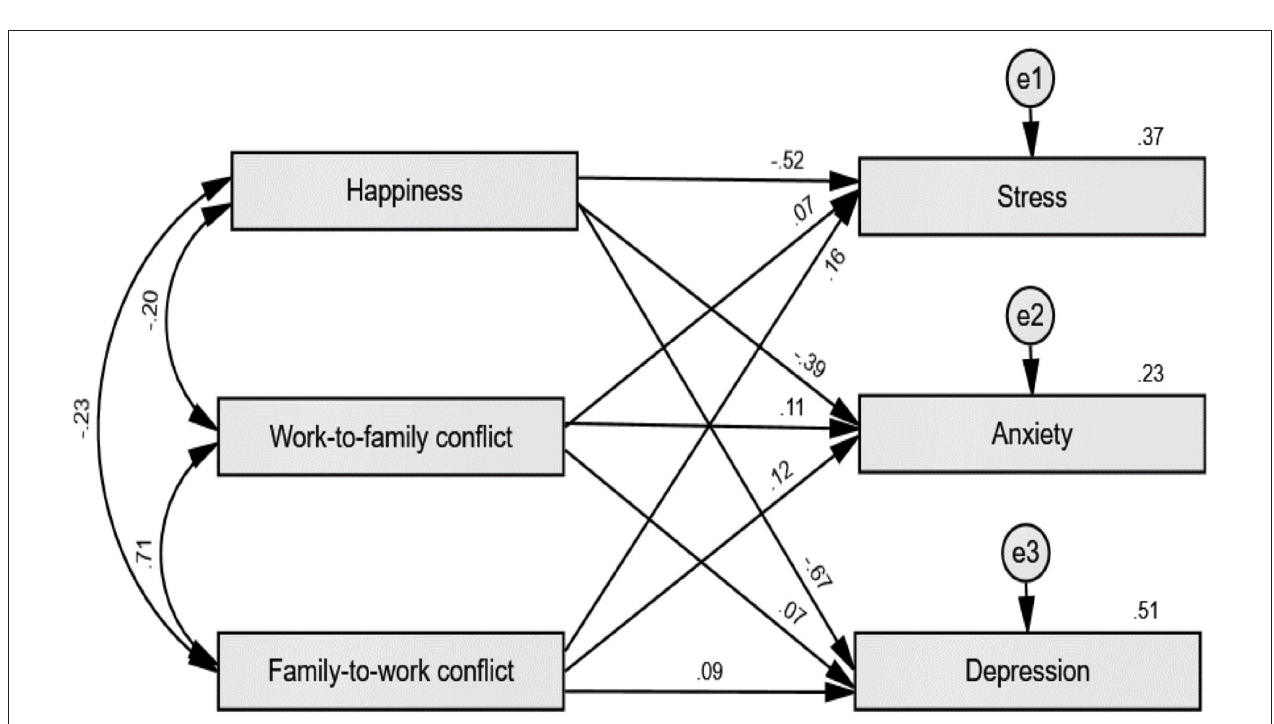
FIGURE 1 | Path analysis model for the significant effects between mental health, happiness, and work-family conflict ( N =